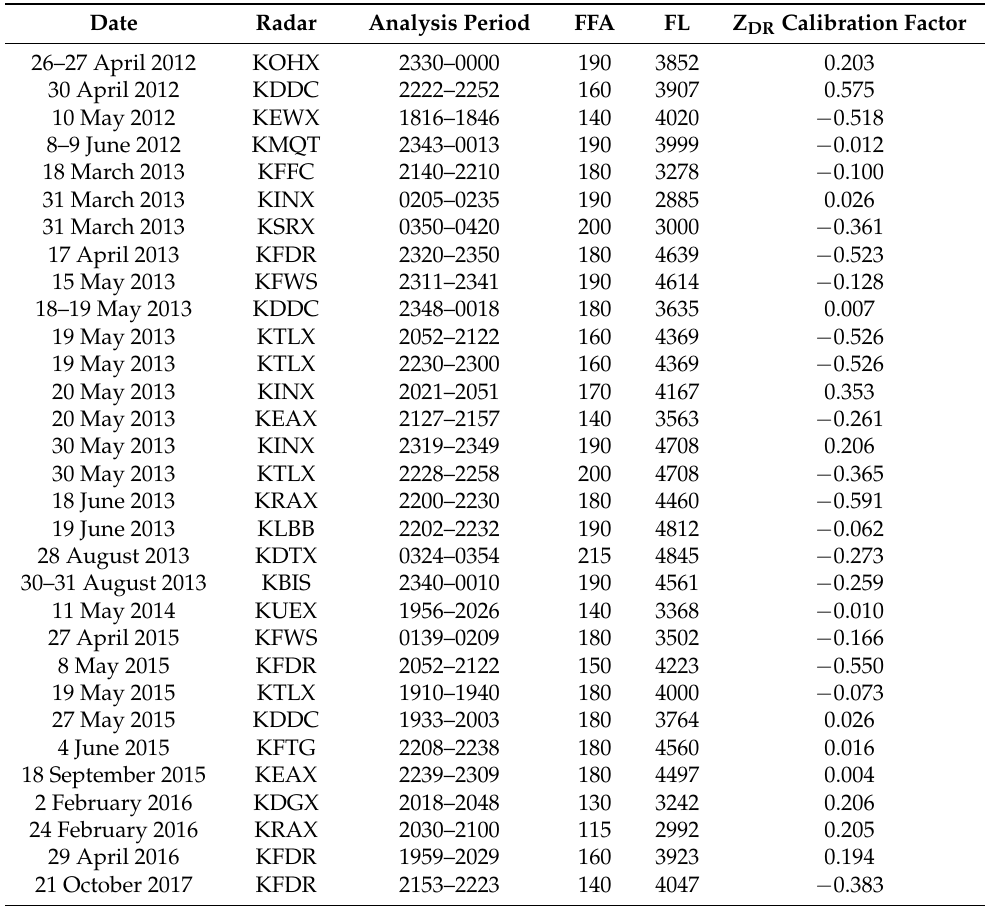
Table 1. The date, radar, analysis period (UTC), forward flank angle (FFA; degrees), freezing level (FL; meters), and Z DR calibration factor (dB) for each of the tornadic cases included in the pre- tornadogenesis analysis. The end of the analysis period is the tornadogenesis